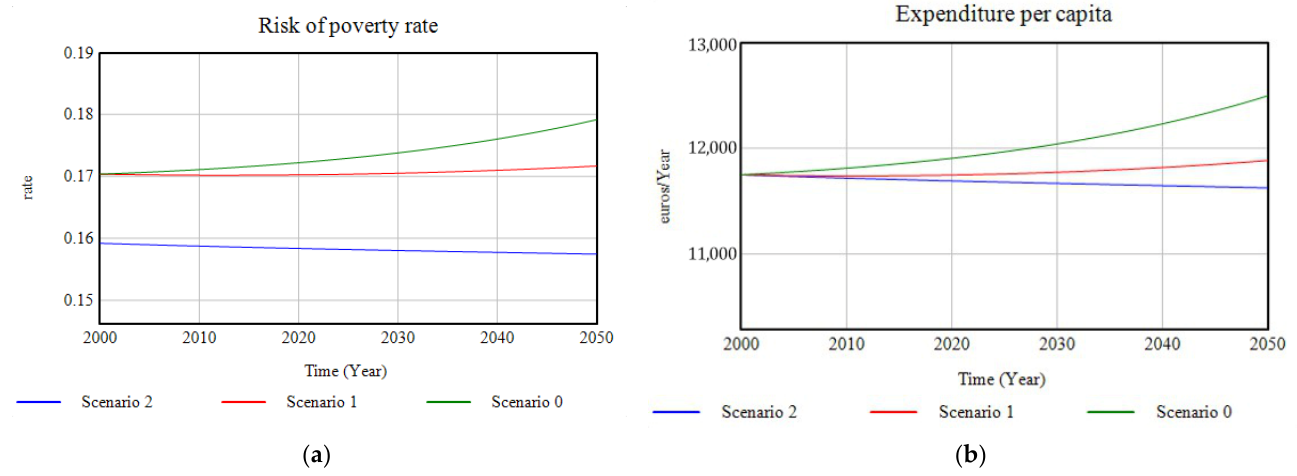
Figure 16. ( a ) Progression of the risk of poverty rate; ( b ) graphic representation of the results of the evolution of the expenditure per capita for the three simulated scenarios in the period 2000–2050.